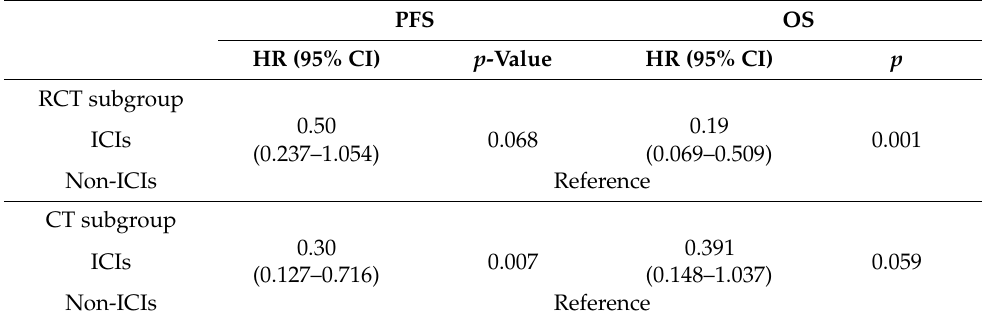
Table 4. Subgroups analysis by COX model.